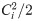
(a) Bibliographic coupling network of the 8673 Physical Review papers published in 1991, PRA purple, PRB turquoise, PRC blue, PRD green, PR Letters red, Reviews of Modern Physics brown. Clusters of all sizes are present. Node size represents the number of citations of these papers in 2011. Clusters are clearly linked by bridging papers. (b) Section of the network, thresholded to link weights two and larger. Node size represents the citation rate during a two-year period after publication, Ci2/2. Many of the immediate citations go to papers close to the cluster centers. (c) Same section for citation rates over a twenty-year period after publication, Ci20/20. For explicit examples and the meaning of the arrows, see S1 Text. Overall, citation rates over twenty years are smaller than for the first two years. Many papers that are relevant on the long timescale appear in the periphery of clusters (out-of-the-box) and between clusters. Most papers close to cluster centers become marginal on the long timescale. Note the positions of PRL papers (red) and review articles (brown). PRL papers attract much short-term attention but are no longer dominant in the long run. One of the two Rev. Mod. Phys. articles appears in the periphery of a big cluster, the other represents a small emergent field.